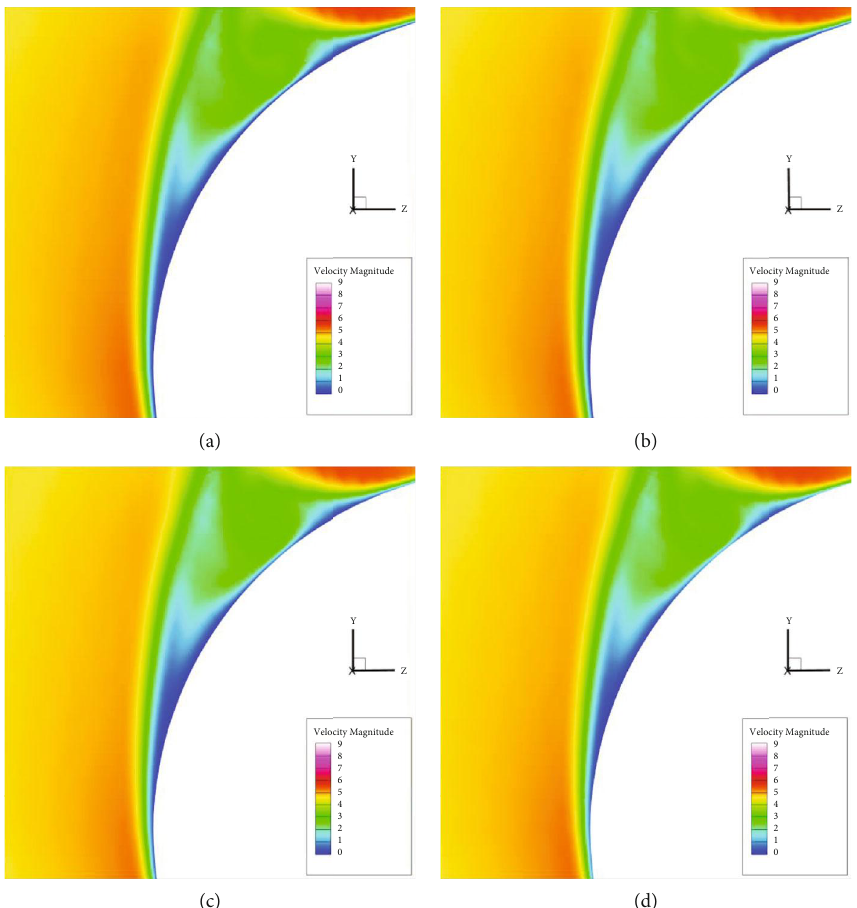
Figure 27: Comparison of closed-wall velocity with di ff erent roughness values at cross-section 1: (a) Model 1, (b) Model 2, (c) Model 3, and (d) Model 4.